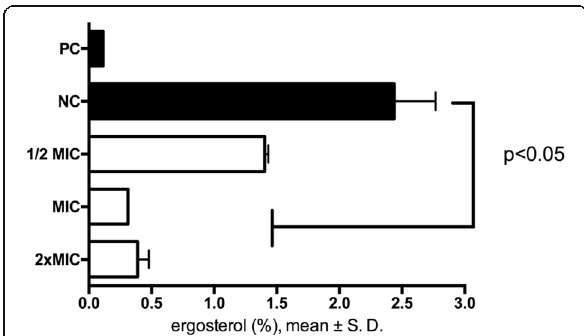
Fig. 4 Modulation of ergosterol content at different concentration of berberine; PC-voriconazole 4 μ g/mL 1 ; NC-intact cells. The data are shown as means ±